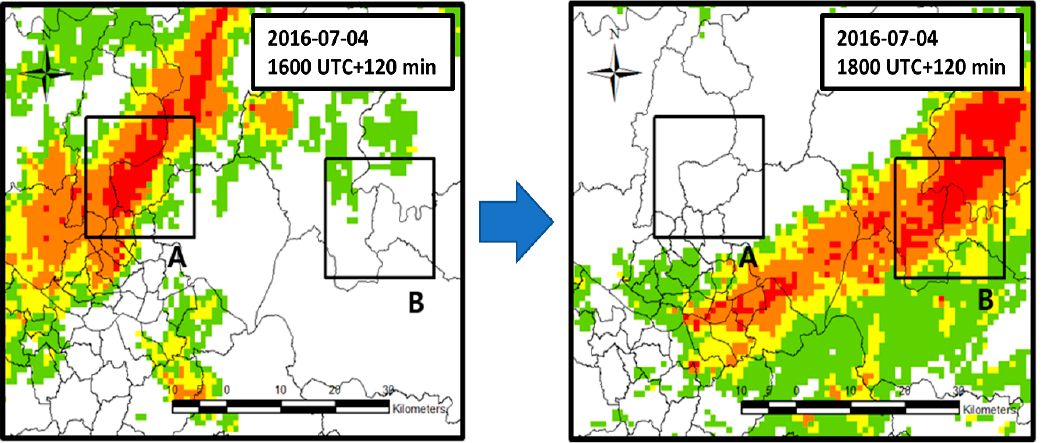
Figure 2. Comparison of the conventional method ( a ) and the proposed method in this study ( b ) for estimating the bias correction ratio.